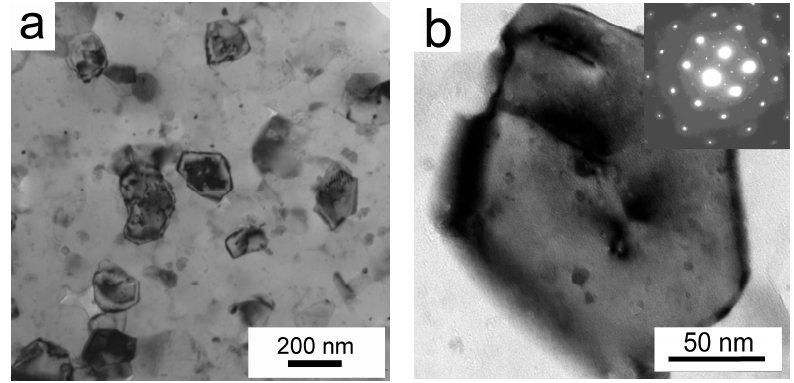
Figure 17. The microstructure of the Al7075Zr_MC compact: ( a ) the sub-microcrystalline microstructure of the sample; ( b ) a grain containing Al 3 Zr particles, TEM.